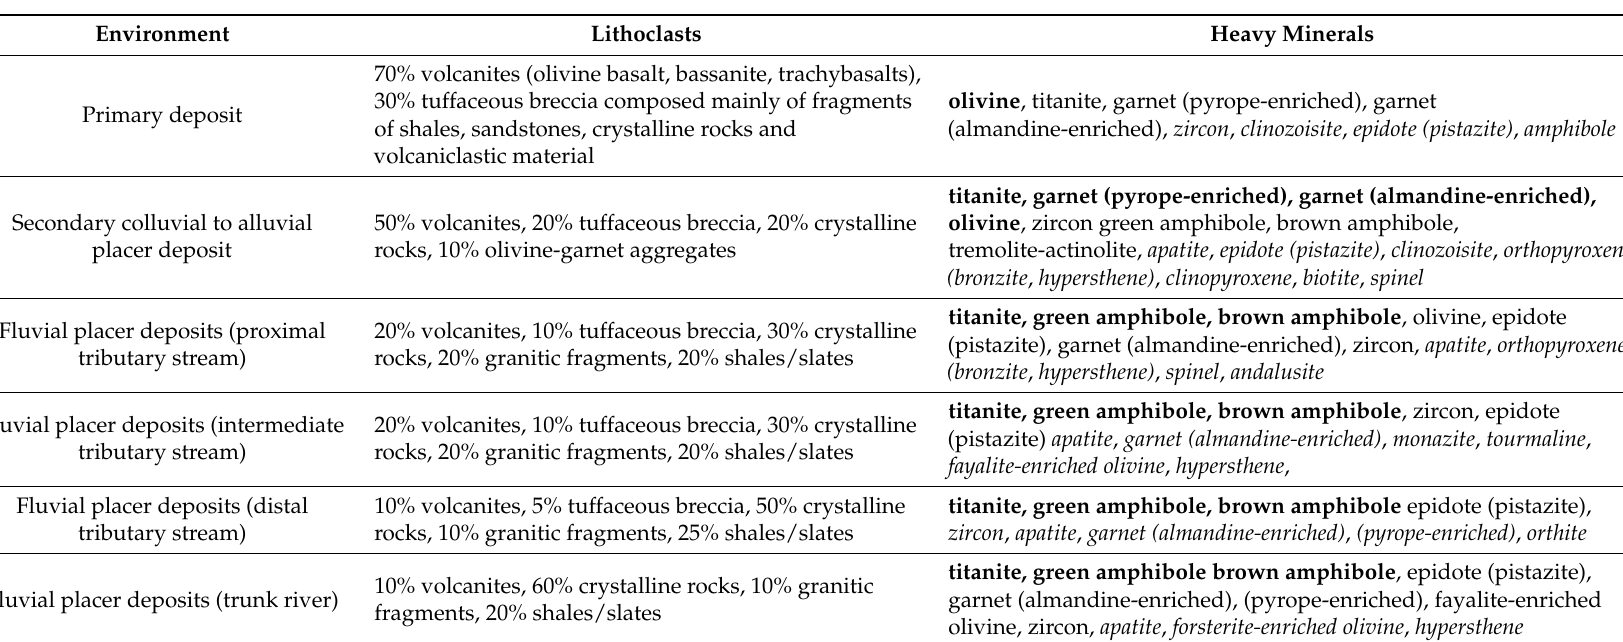
Table 3. Lithoclast- and heavy mineral variation along the thalweg from the primary source through the different colluvial, alluvial and fluvial placer deposits in a diamondiferous olivine-garnet placer deposit, Mongolia (modified from Dill et al.)